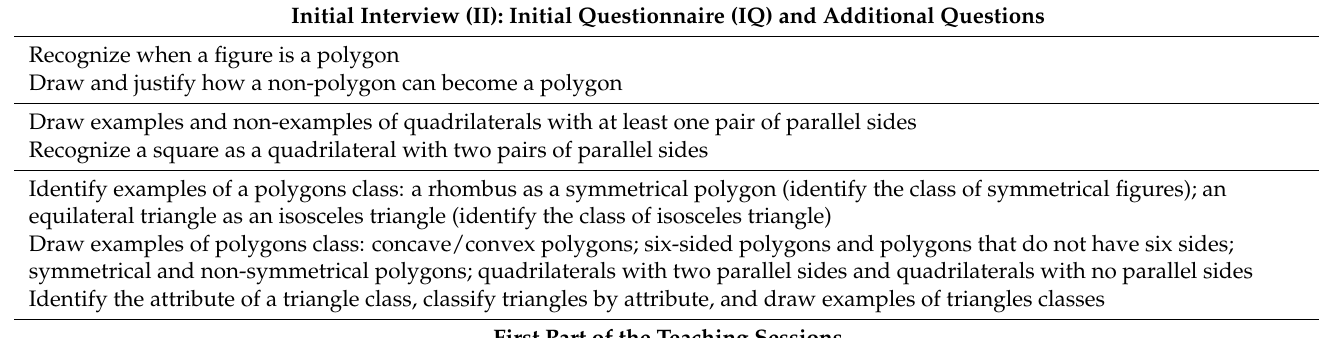
Table 1. Teaching experiment: interviews, questionnaires, and